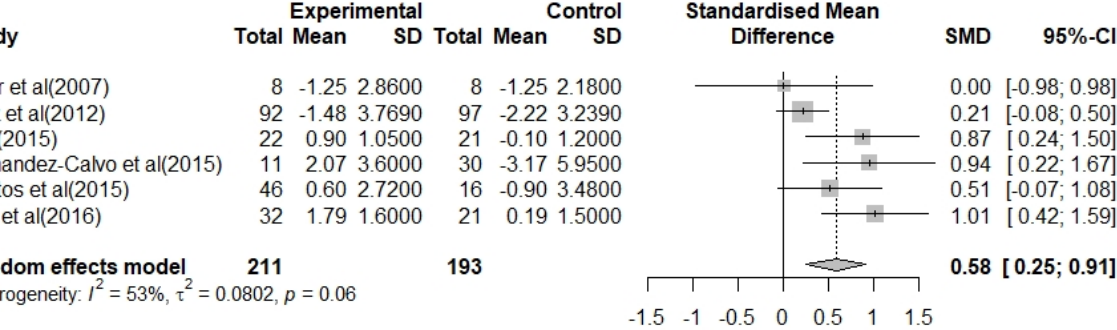
Figure 3. Forest plot for the effects of the multimodal occupational therapy program with cognition-oriented approach on cognitive decline in patients with AD.